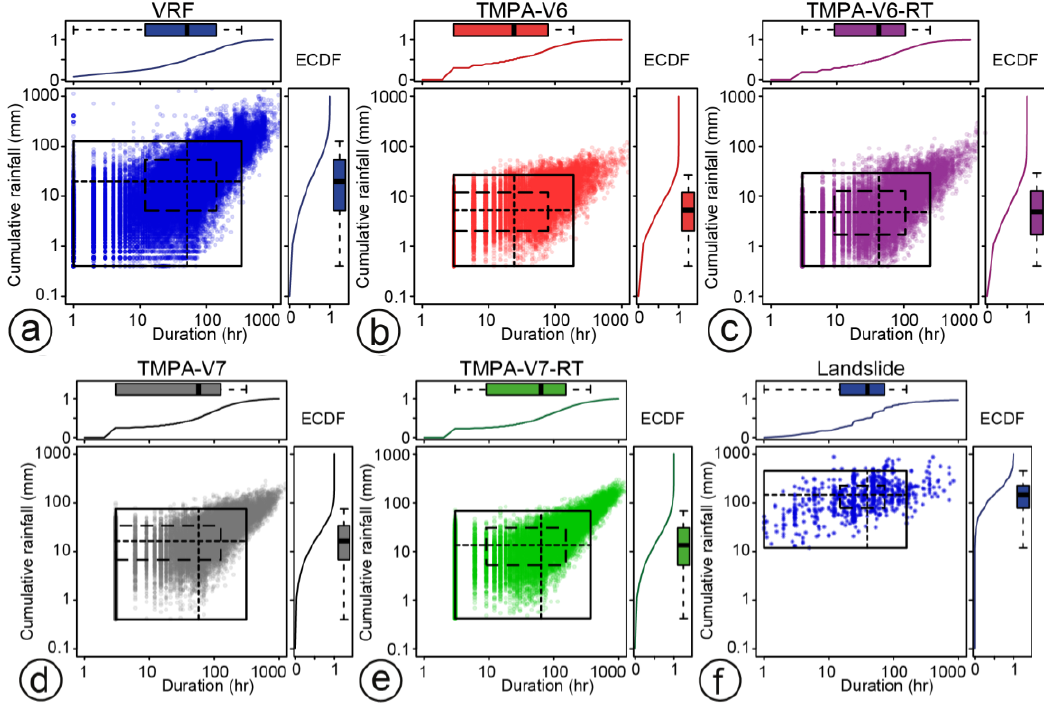
Figure 17. Duration and cumulative rainfall of the events detected by the automatic procedure in the entire Italian territory in the period September 2009–August 2010 for the VRF data ( a ) and for the TMPA-V6 ( b ), TMPA-V6-RT ( c ), TMPA-V7 ( d ), TMPA-V7-RT ( e ) satellite rainfall estimates. ( f ) Rainfall events associated with landslides in the Italian territory. The boxplots and the ECDF plots (lines) describe the empirical distributions of the duration and cumulative rainfall of the events. Overlapped quantile grids (drawn from the marginal boxplot values) highlight the bivariate median (dotted lines), the bivariate interquartile ranges (dashed lines) and bivariate notches ranges (solid lines) of the rainfall events.